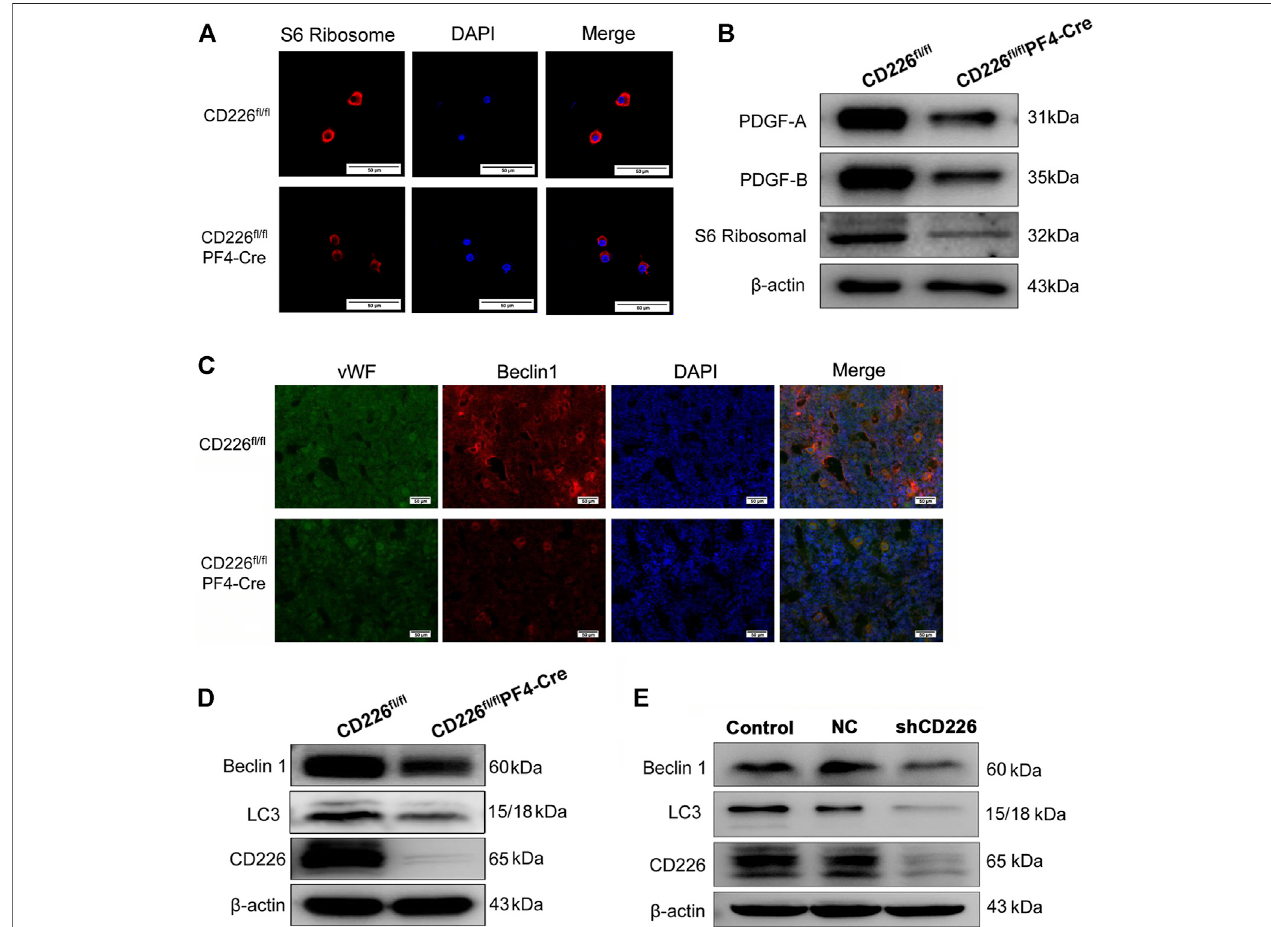
FIGURE 4 | CD226 de fi ciency in platelets decreased the ribosome and autophagy related protein expression in MK/platelets and human Dami cells. (A) S6 ribosomal protein-expressing ribosome in isolated MKs from BM. Scale bar (cid:1) 50 µm. (B) Lysates of freshly isolated mice platelets were subjected to western blot with anti-S6 ribosomal, PDGF-A, and PDGF-B antibodies. (C) Double immuno fl uorescence staining for vWF and Beclin1 in the BM slides from CD226 fl / fl PF4-Cre and CD226 fl / fl mice.Scale bar (cid:1) 50 µm. (D) Lysatesoffreshlyisolatedmice plateletsweresubjectedtowesternblotwithanti-LC3,Beclin1,andCD226antibodies. (E) Dami cells infected with lentivirus shCD226 were subjected to western blot with anti-LC3, Beclin 1, and CD226 antibodies.